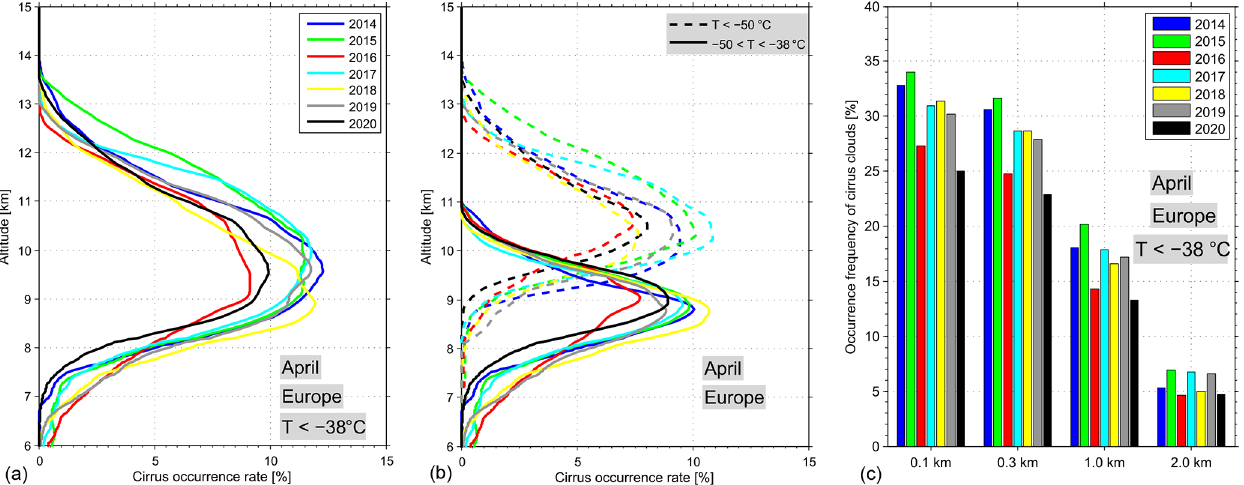
Figure 6. Occurrence rates (ORs) of cirrus clouds derived from the lidar measurements of CALIPSO in April in different years from 2014 to 2020. Only observations of cirrus clouds at temperatures below − 38 ◦ C, at altitudes above 6km and with cloud thickness larger than 0.1km, are analyzed. (a) Altitude profiles of cirrus OR derived from all the observations with T < − 38 ◦ C. (b) Altitude profiles of cirrus OR with T < − 50 ◦ C (dashed lines) and with − 50 < T < − 38 ◦ C (solid lines). (c) Histograms of the occurrence frequency according to the definitions of different cloud thicknesses, respectively.